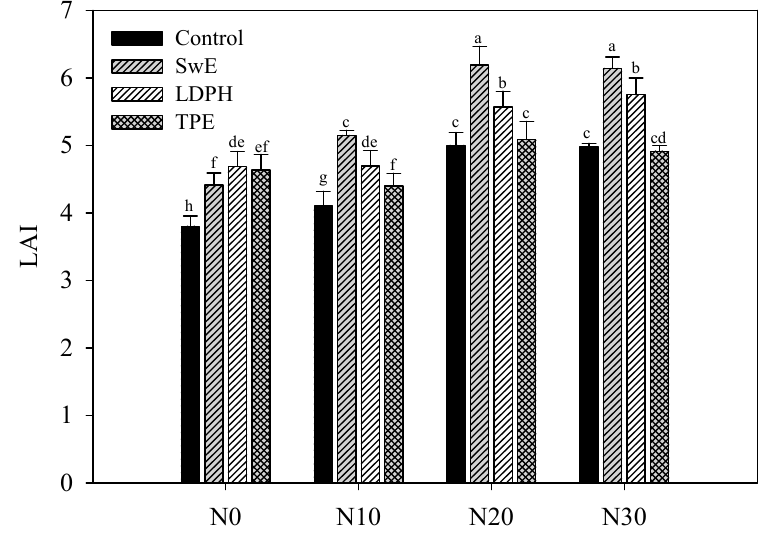
Figure 3. Effects of nitrogen (N) fertilization levels (0, 10, 20 and 30 kg N·ha − 1 ; N0, N10, N20 and N30, respectively) and biostimulant applications (untreated control, SwE: Extract of seaweed Ecklonia maxima , LDPH: Legume-derived protein hydrolysate and TPE: Tropical plant extract) on the leaf area index (LAI) of baby lettuce plants. Different letters indicate significant differences according to the Duncan’s test (significance level 0.05).